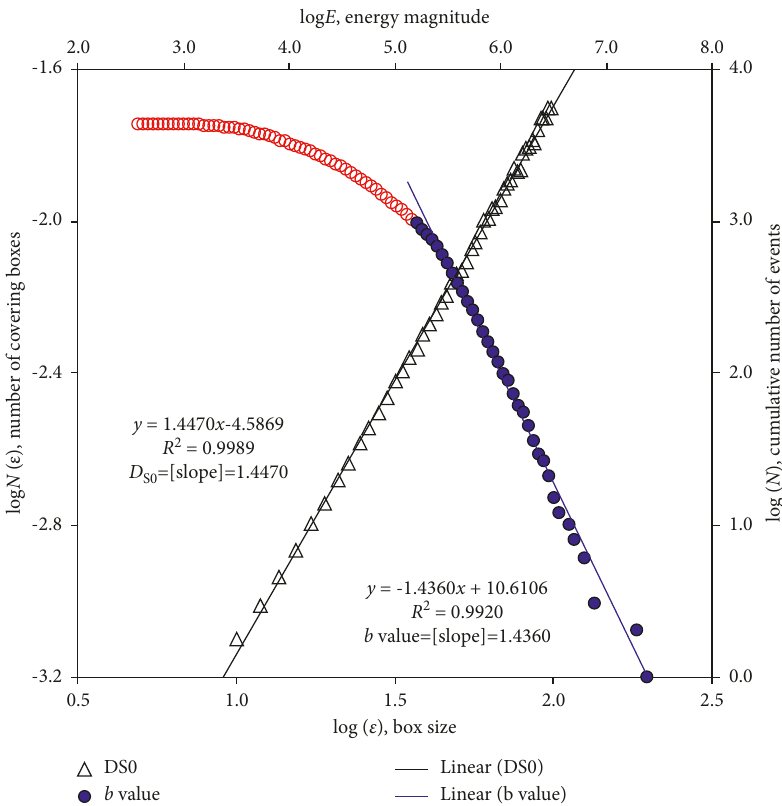
Figure 4: Comparisons between fractal dimension and b value in Gutenberg–Richter